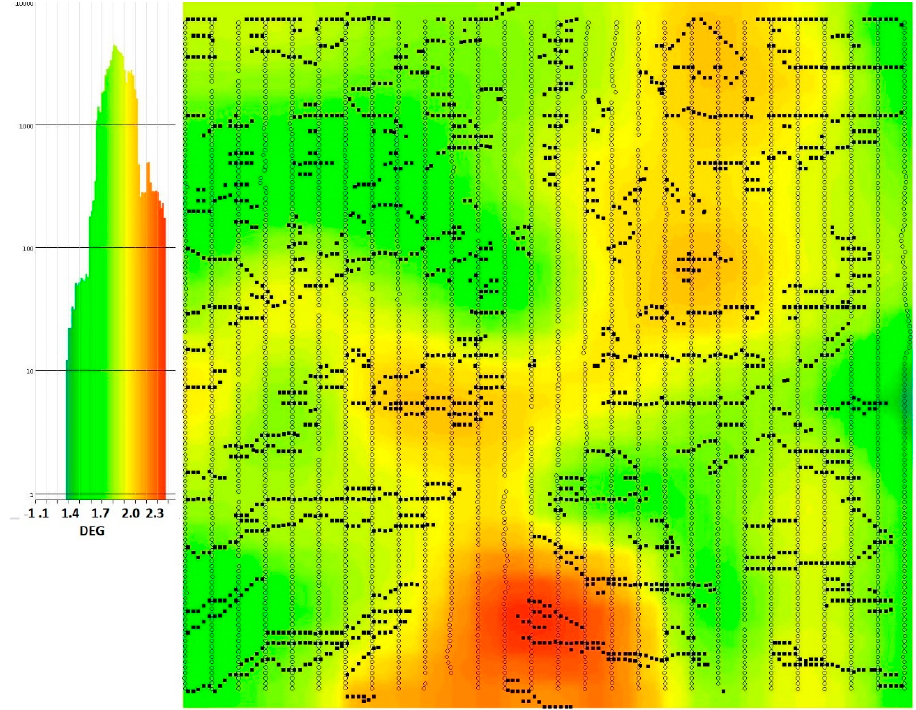
Figure 10. A map of anisotropy azimuths. The circles represent receivers, and the squares represent sources.